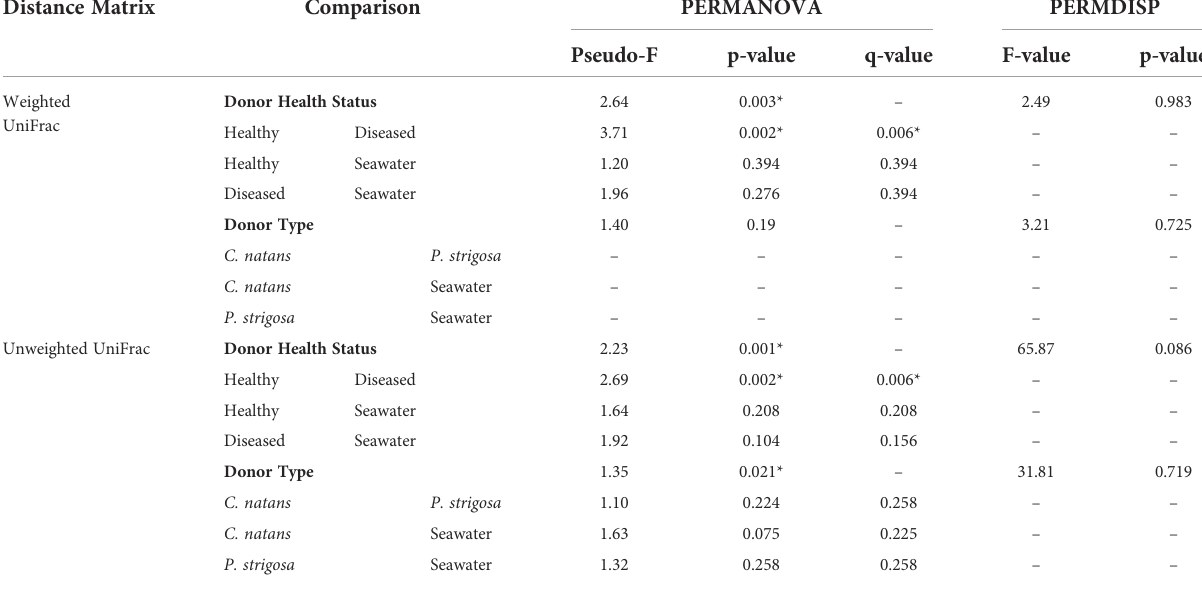
TABLE 1 Comparisons of microbial community structure and dispersion between samples based on Donor Health Status (conditions “ diseased, ” “ healthy, ” or “ seawater ” ) and Donor Type (conditions “ Colpophyllia natans , ” “ Pseudodiploria strigosa , ” or “ seawater ” ). Distance Matrix